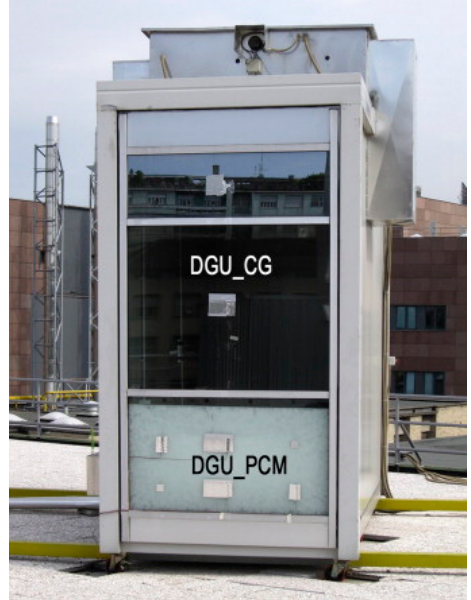
Figure 7. Test cells composing DGU with clear glasses and DGU-PCM [31,32].